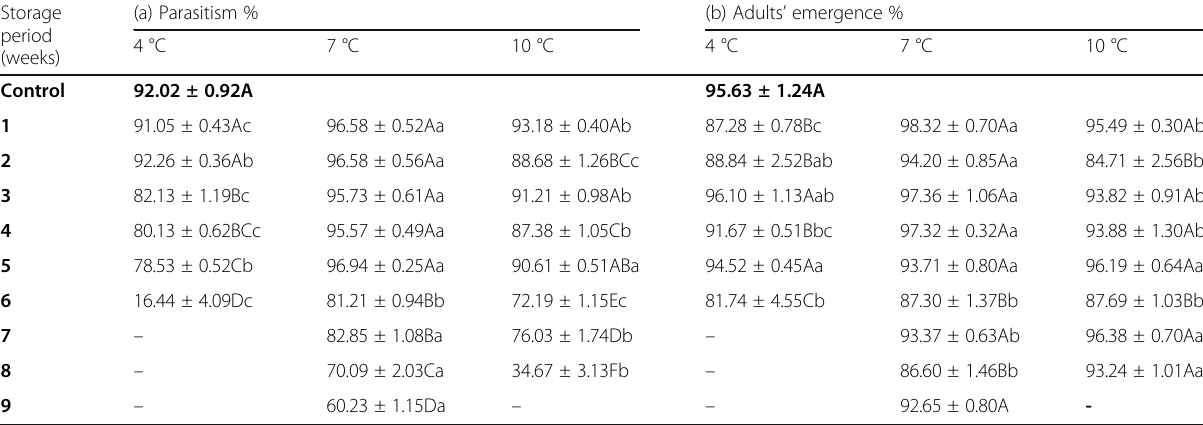
Table 6 Percentages of parasitism and adults ’ emergence of Trichogrammatoidea bactrae in F 1 progeny during storage of parasitoid pre-pupae at different low temperatures Storage